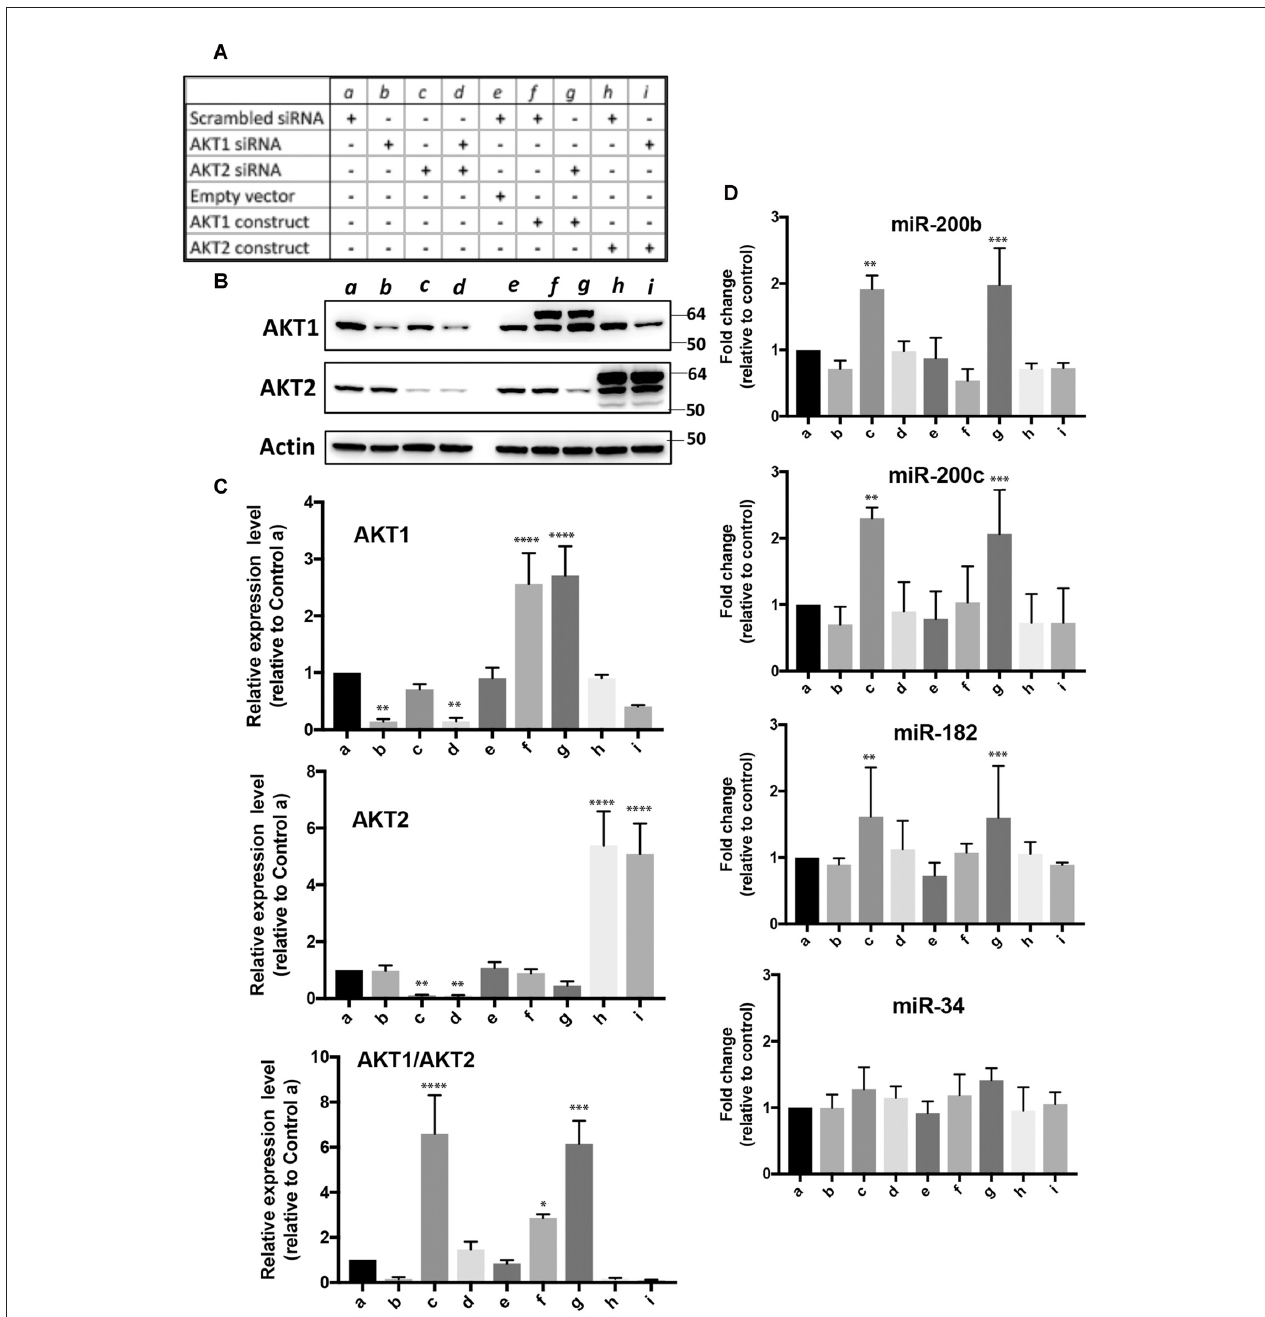
FIGURE 5 | Effect of over-expression and/or depletion of Akt1 and/or Akt2 on the expression of miR-200b, c, miR-182 and miR-34 in SHSY5Y cells. (A) Nine conditions (a–i) for overexpression or depletion of Akt isoforms used in this experiment. (B) Representative immunoblots of Akt1 and Akt2 proteins under these nine conditions. (C) Quantitative analyses of Akt1 and/or Akt2 protein expressions, and the ratio of Akt1/Akt2 expressions. (D) Expressions of miR-200b, c, miR-182 and miR-34 under these nine conditions. Quantitation data represent the mean ± SD of at least three independent experiments. The statistical analyses were shown relative to the control group a. ∗ p < 0.05, ∗∗ p < 0.01, ∗∗∗ p < 0.001, ∗∗∗∗ p <